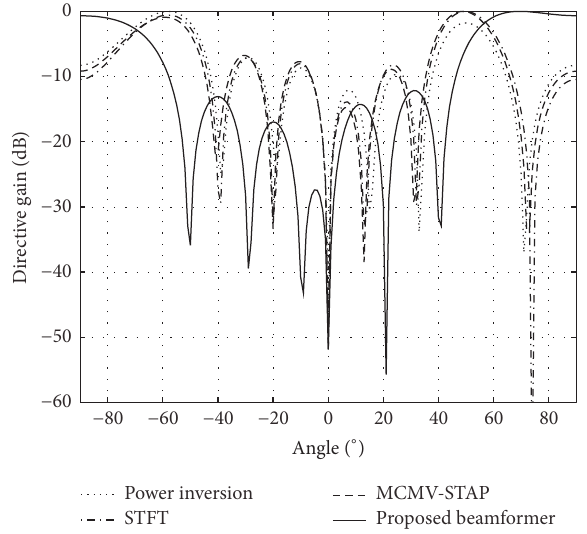
Figure 13: The array antenna pattern of antijamming for different method: the angle of arrival of the satellite signal is 70 degrees and the angles of arrival of jamming signals are 72 degrees and 0